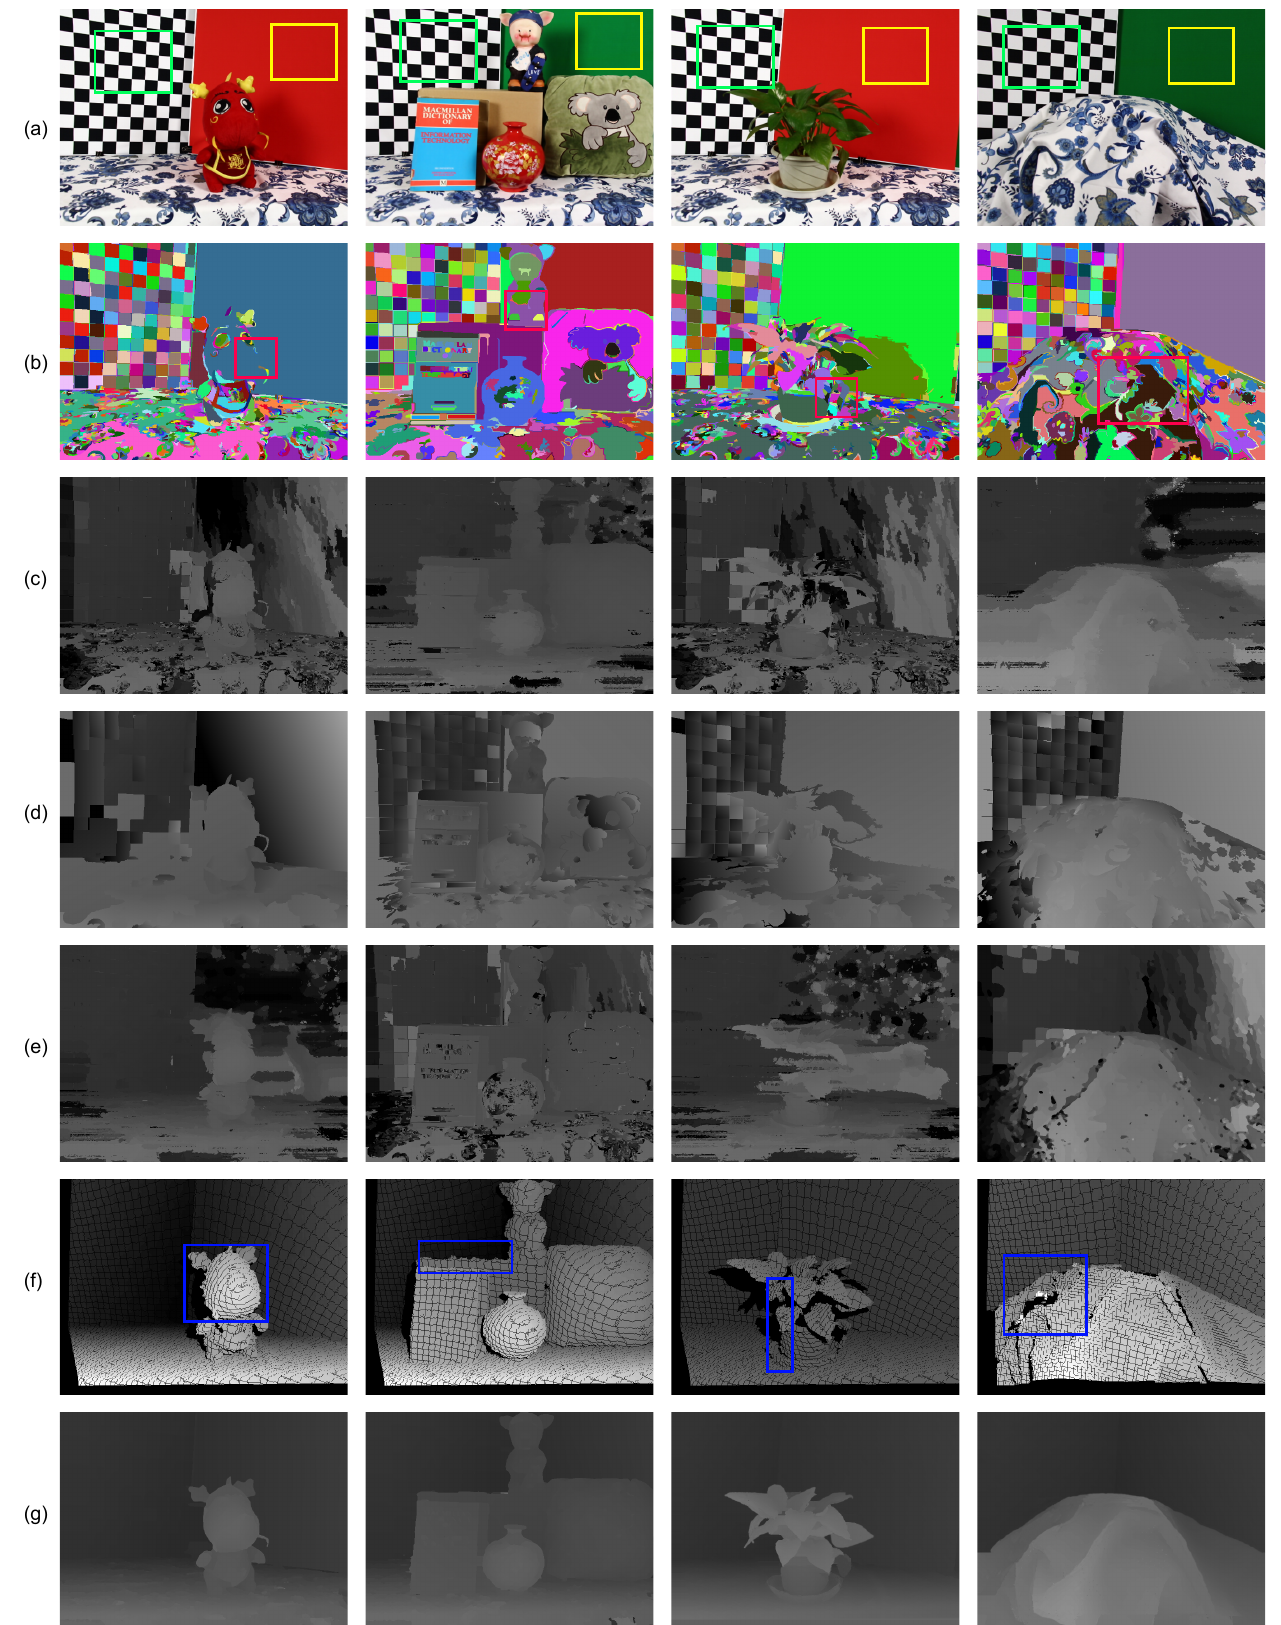
Figure 7. Results of the different methods applied to the real-world scenes: Dragon, Book, Plant and Tablecloth. Each column from up to down is: ( a ) the rectified left image; ( b ) the segmentation result, ( c ) the disparity map of FCVF [44]; ( d ) the disparity map of SOSP [11]; ( e ) the disparity map of segment tree (ST) [13]; ( f ) the seed image transformed from the Xtion data and ( g ) our